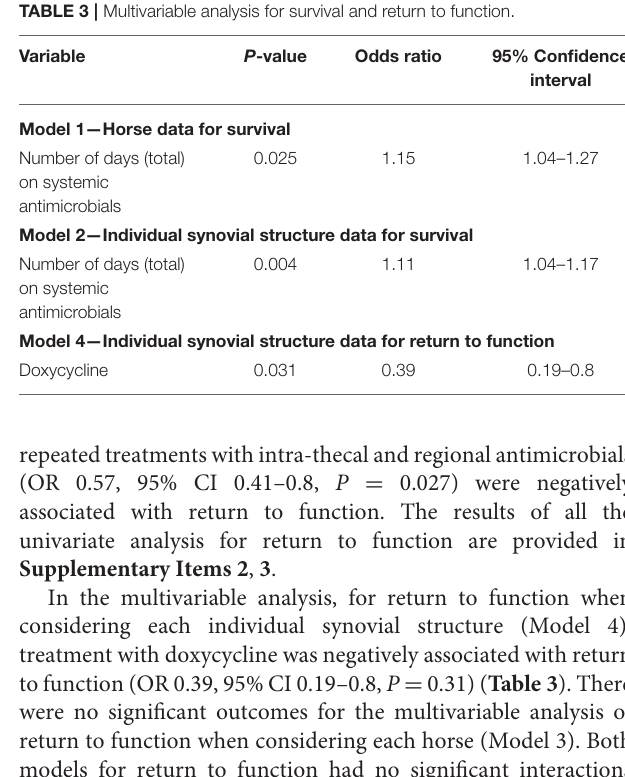
TABLE 3 | Multivariable analysis for survival and return to function. Variable